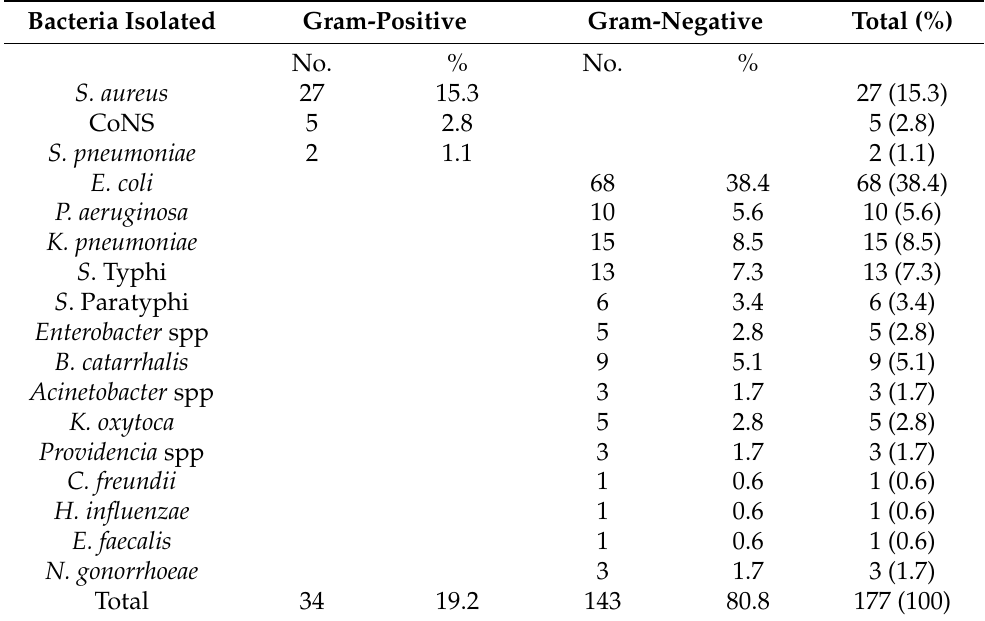
Table 1. Growth status of Gram-positive and Gram-negative bacterial isolates ( n = 177).